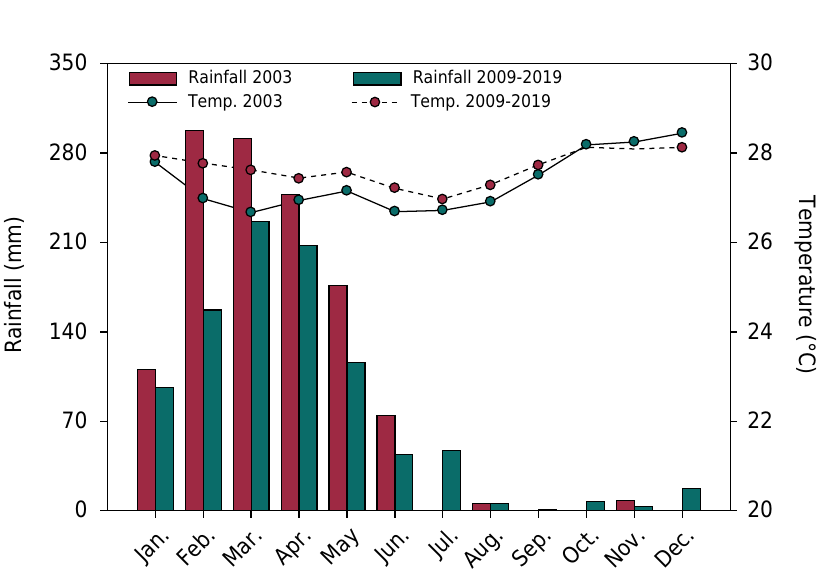
Figure 1. Climatic data throughout the year of data collection (2003 and series of average monthly rainfall and temperature in the last 10 years - 2009-2019) in the municipality of Pacajus, Ceará, Brazil. Temperature data is from the Fortaleza station, where the climate is similar to